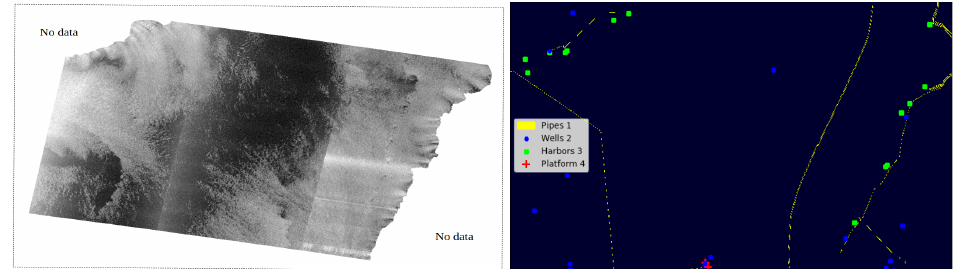
Figure 9. Illustration of the position of infrastructures associated with the SAR image on 15 October 2018 in the Lebanon area. On the left , SAR image, on the right , the associated infrastructures